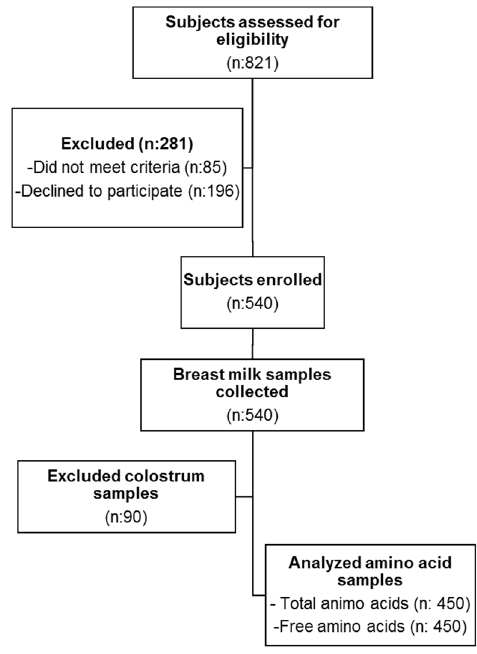
Figure 1. Study flow chart.